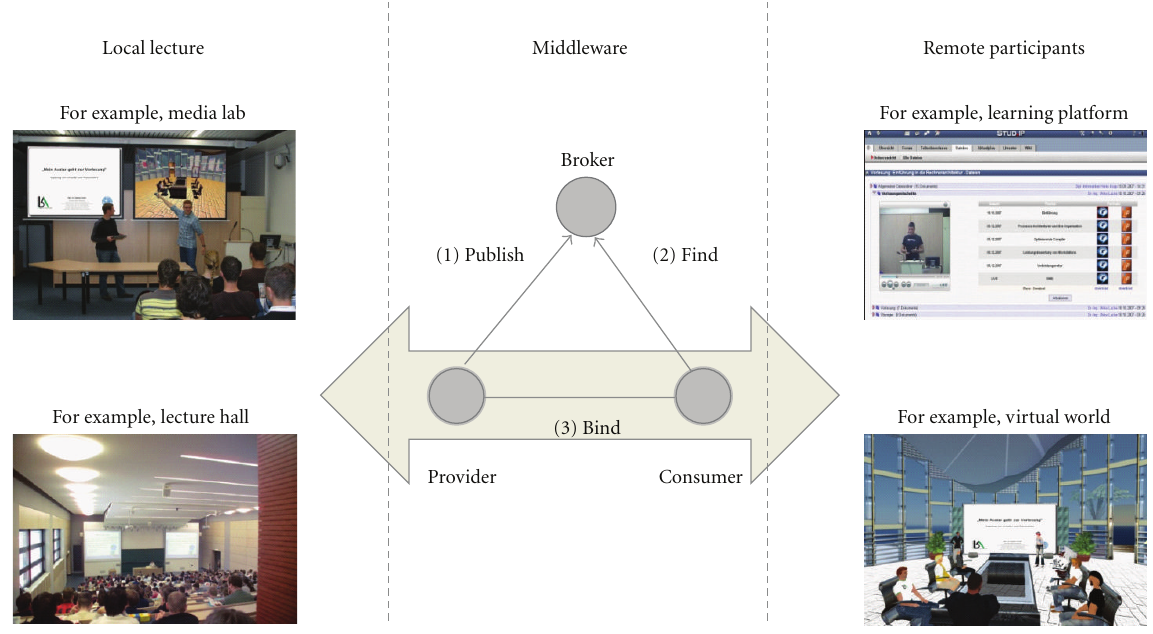
Figure 1: A Service-Oriented Architecture transparently interconnects di ff erent service providers and consumers (here: for telelecturing) without requiring the clients to have specific knowledge on given infrastructure and